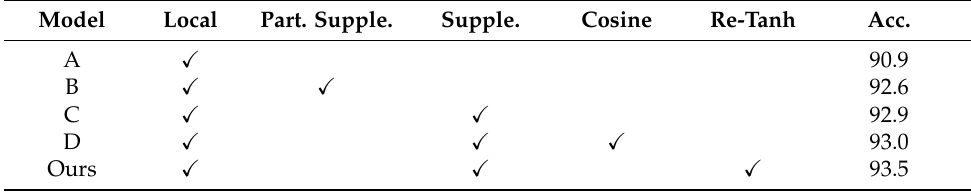
Table 5. Ablation studies of the proposed model (%).